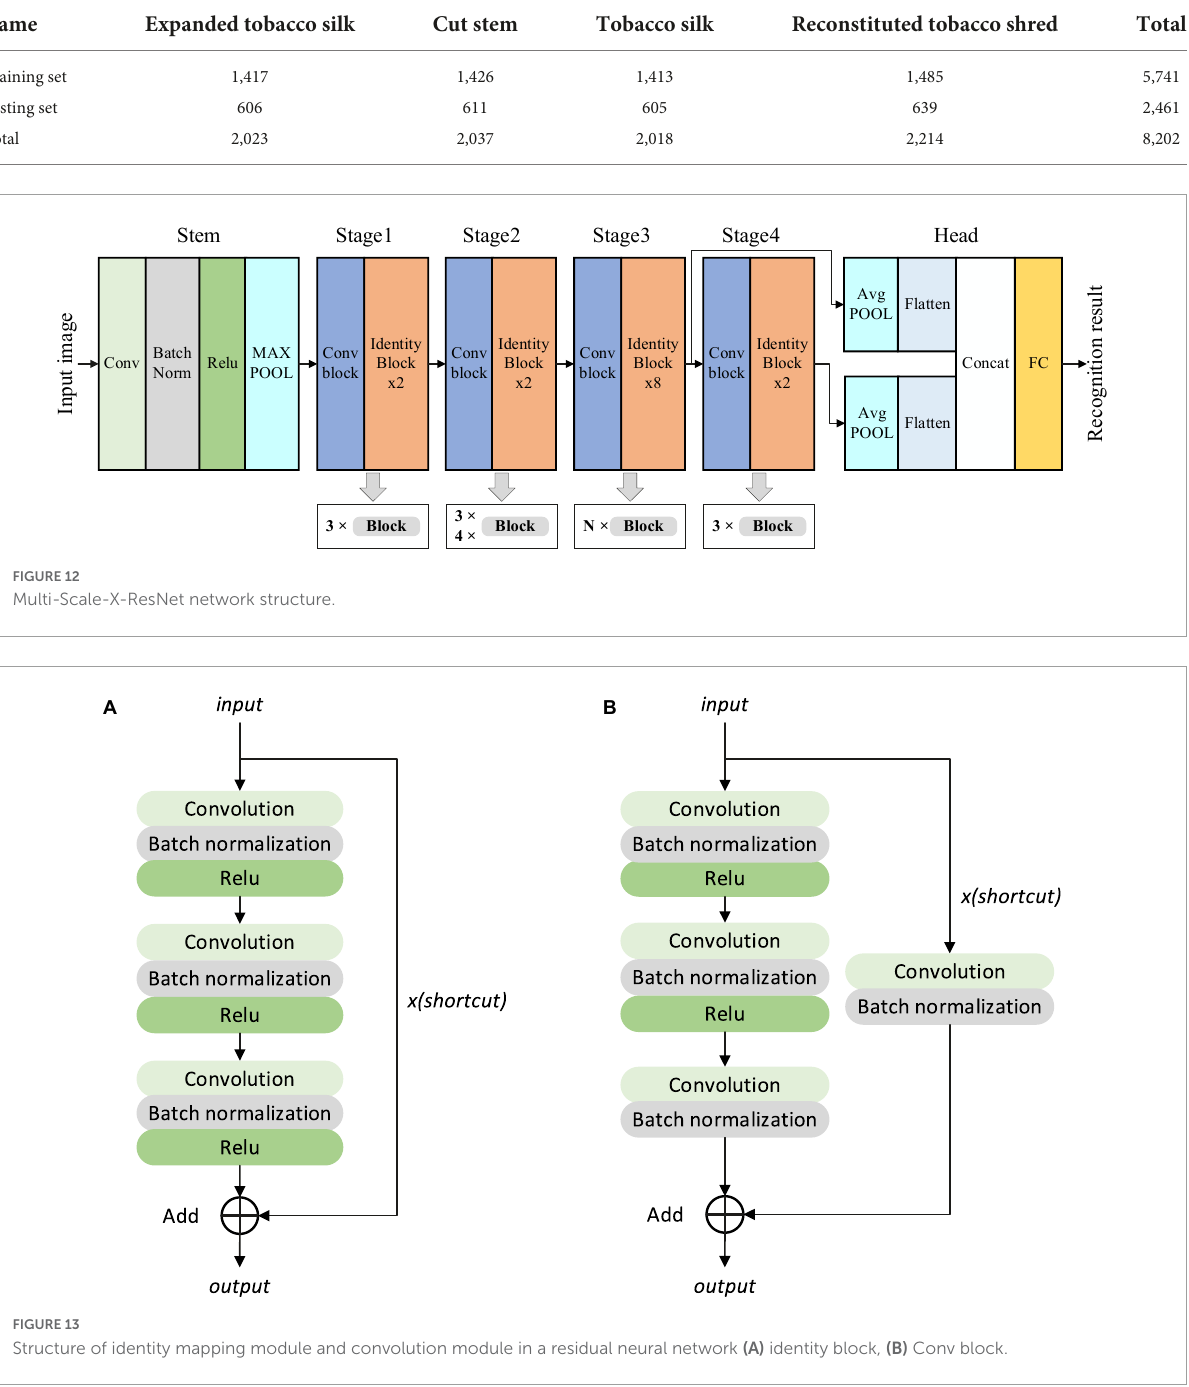
training process (Bishop and Nasrabadi, 2006; Xiao Z. et al.,